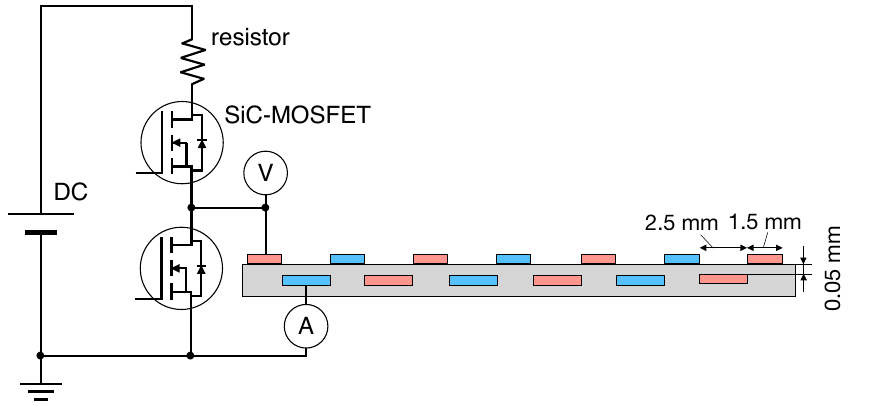
Figure 1. Schematic diagram of the electrical circuit for driving the DBD plasma actuator. Electrode arrangement and size of the DBD plasma actuator are also